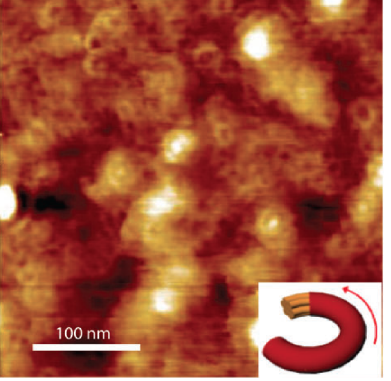
Figure 7. AFM image of spin-coated CDT–BTZ–C16 copolymer film showing ring-shaped structures (Reprinted with permission from Reference [78]. Copyright (2012) by Wiley-VCH Verlag GmbH & Co.).